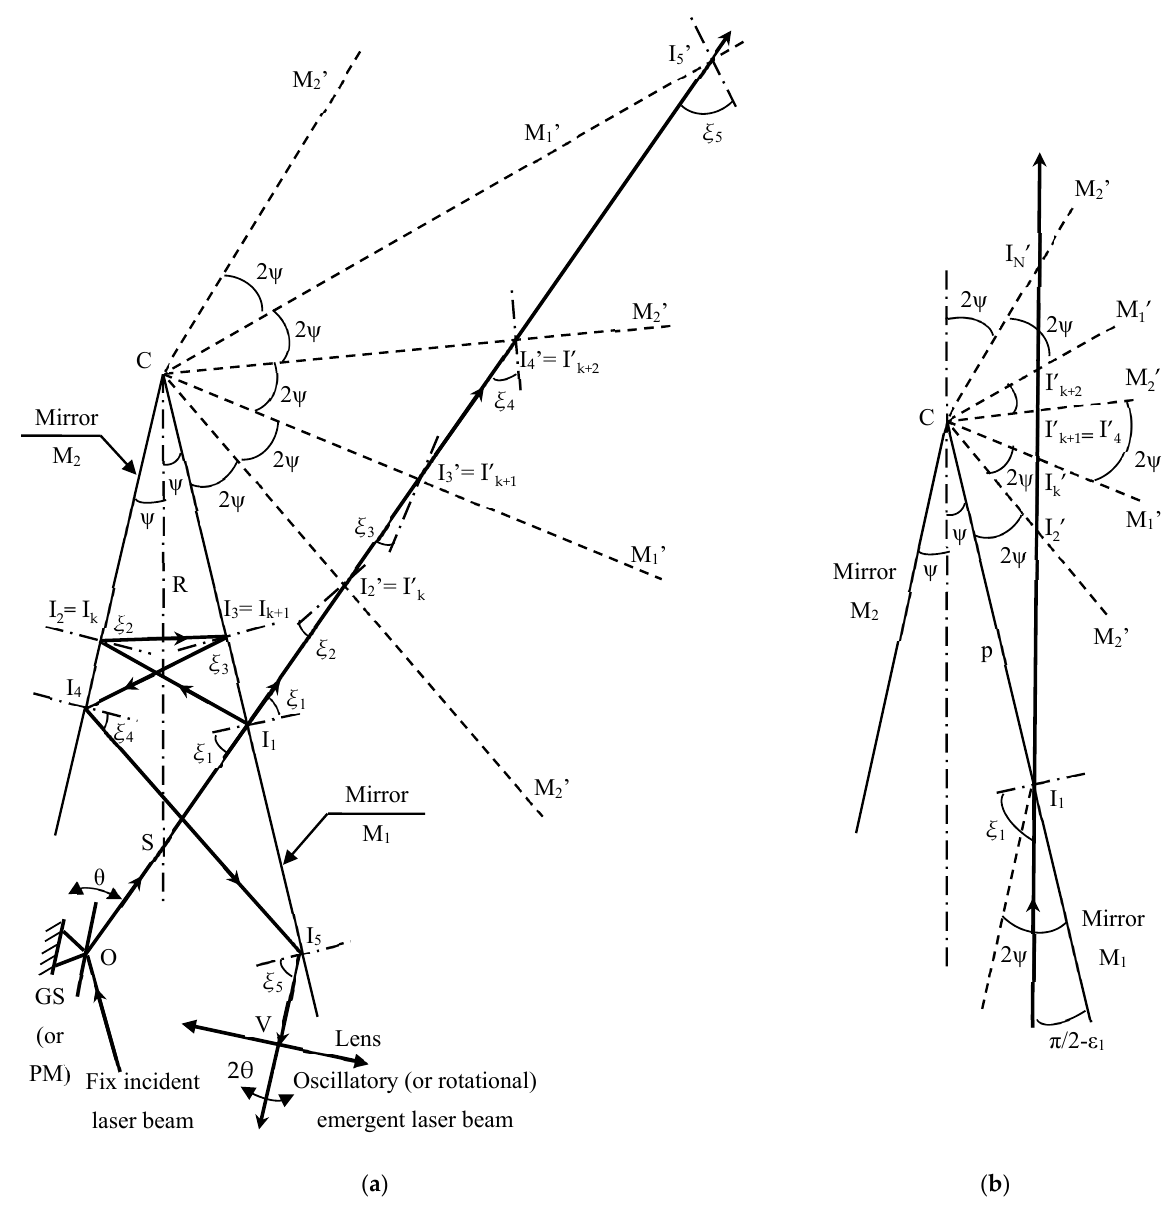
Figure 9. ( a ) Multiple image formation for a small angle between two fixed mirrors—for the device placed between a laser scanning mirror (an oscillatory one of a GS is shown as example) and its objective lens; ( b ) ascertainment of the maximum possible number N of reflections between the two fixed mirrors.